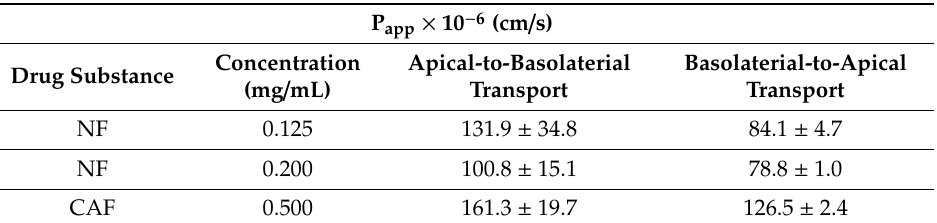
Figure 2. The experimentally ( ♦ ) and theoretically ( ) determined “cumulative fraction transported” of naftidrofuryl oxalate (NF) and caffeine (CAF) versus time in bidirectional A–B and B–A transport across Caco-2 cell monolayer. NF concentrations in donor compartments were established at 0.125 mg/mL ( A ) and 0.200 mg/mL ( B ). CAF transport was analyzed at an initial concentration of 0.5 mg/mL ( C ). Table 4. Apparent permeability coefficients (P app ) of naftidrofuryl oxalate (NF) and caffeine (CAF) determined in the Caco-2 intestinal barrier model ( n = 3).